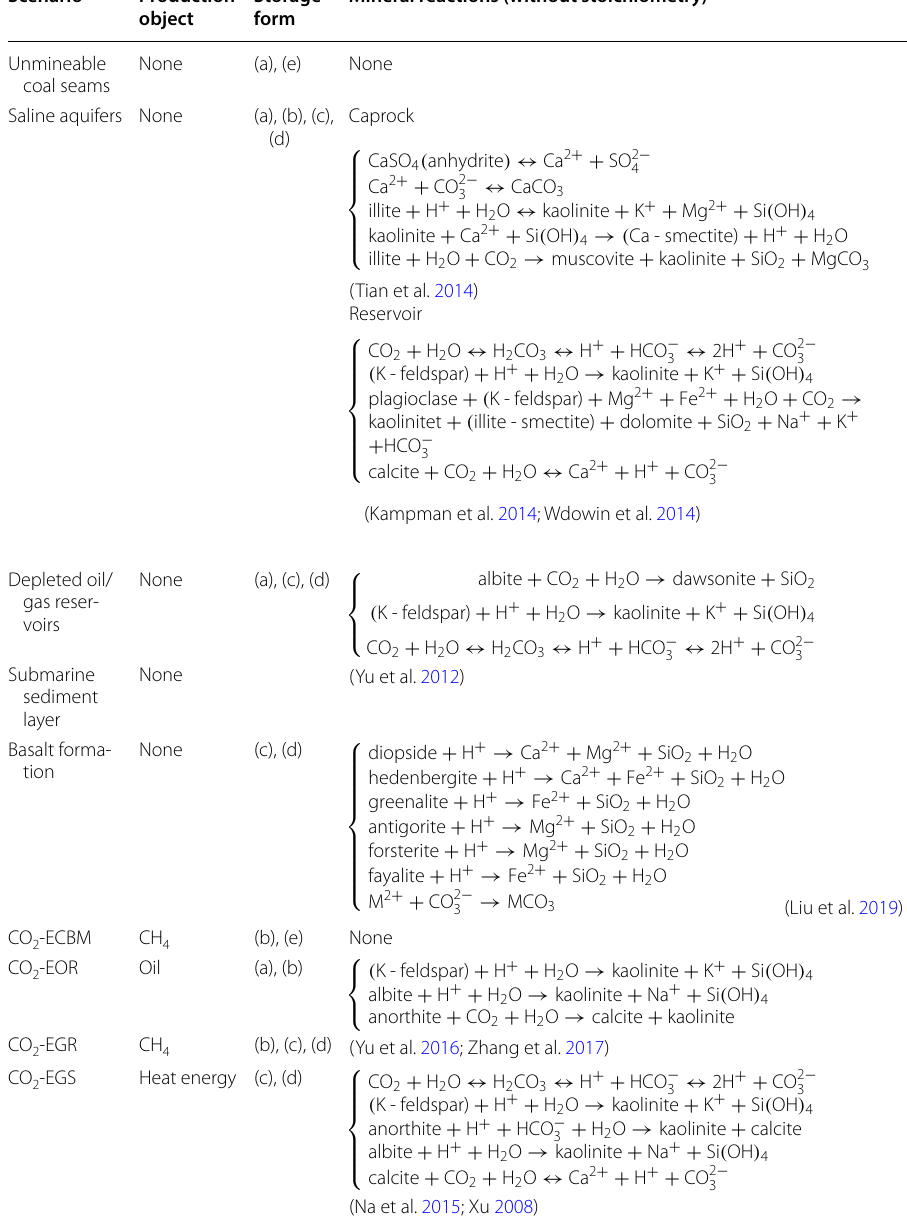
Table 1 CO storage form under each 2